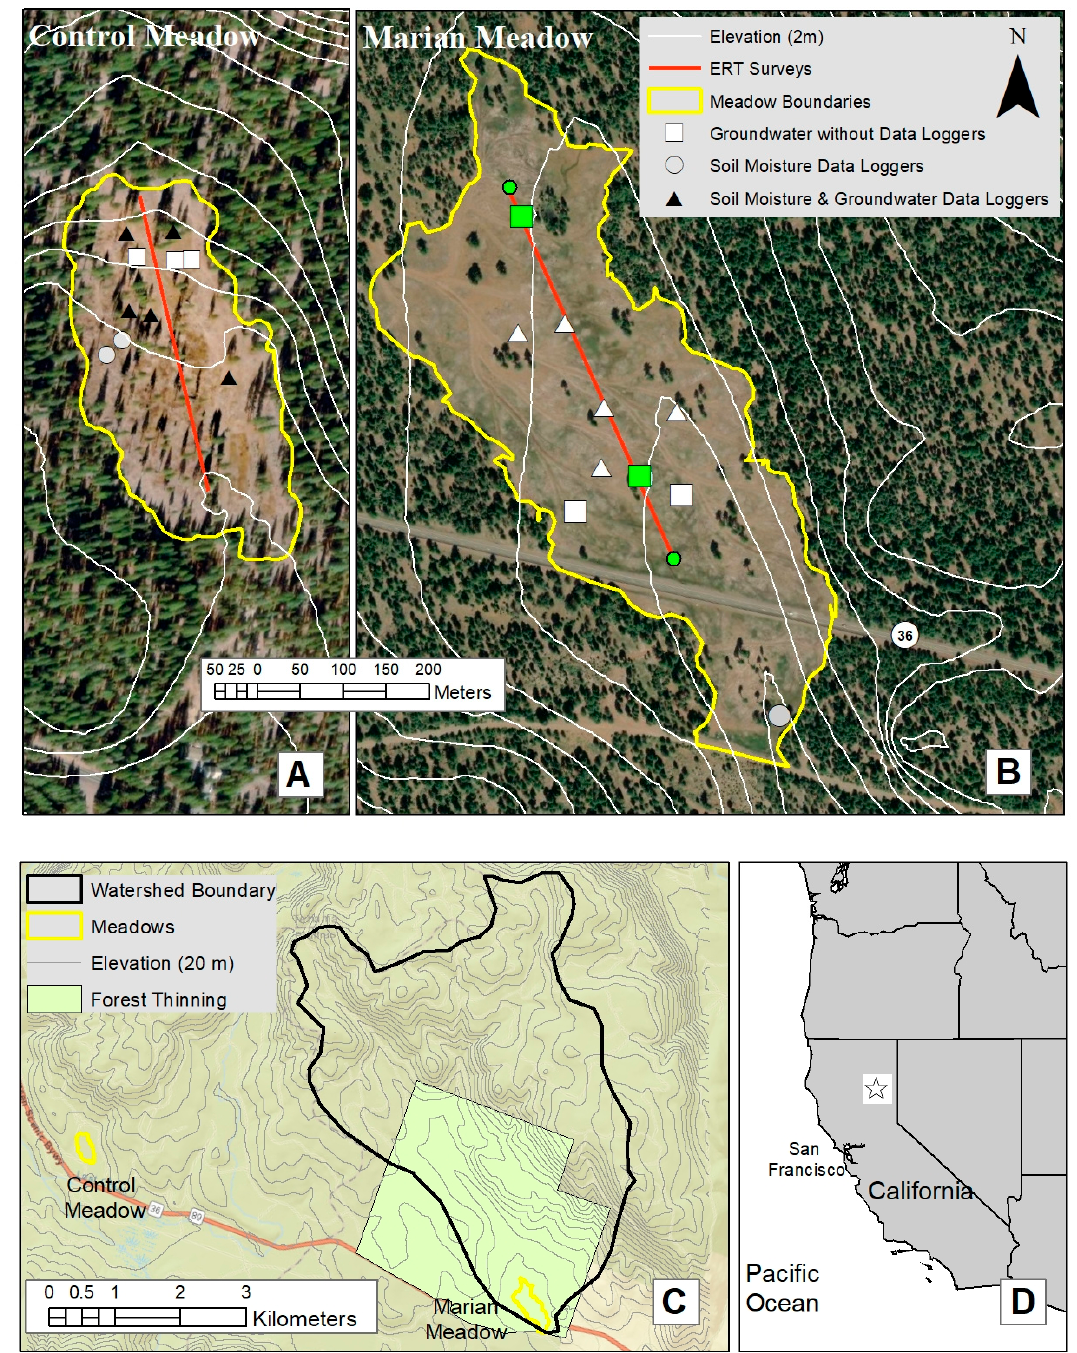
Figure 1. Marian Meadow and Control Meadow study areas. Soil moisture, groundwater depth, and electrical resistivity tomography (ERT) measurements shown. ( A ) Control Meadow. ( B ) Marian Meadow. ( C ) Marian Meadow watershed and area of forest thinning. ( D ) Study sites in relation to California, USA. Satellite imagery and base maps from the Earth System Research Institute (ESRI). Figure adapted from Surfleet et al. [10].